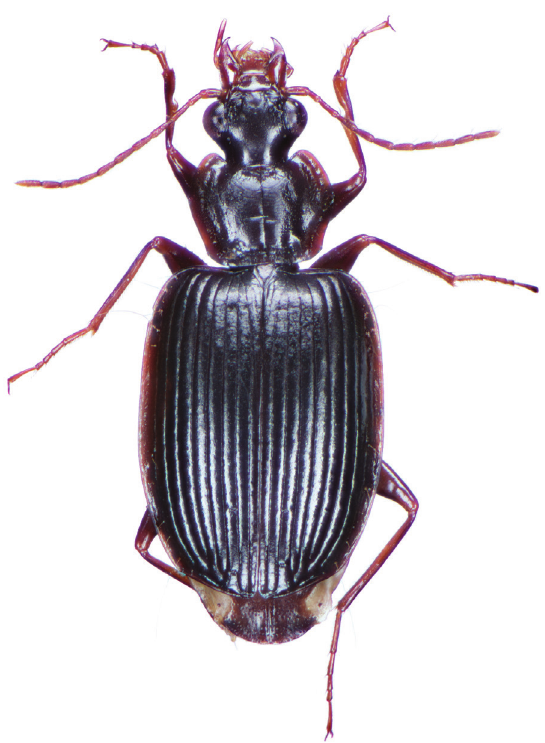
Figure 95. Dorsal habitus and color pattern of Mochtherus luctuosus Putzeys. (OBL 8. 43